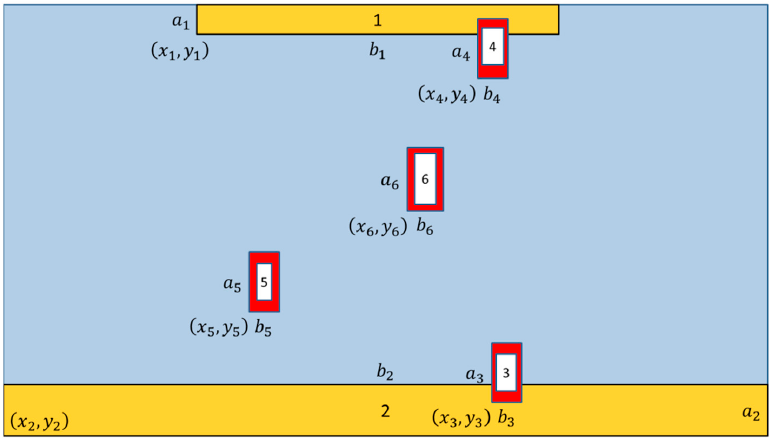
Figure 7. Region of interest.